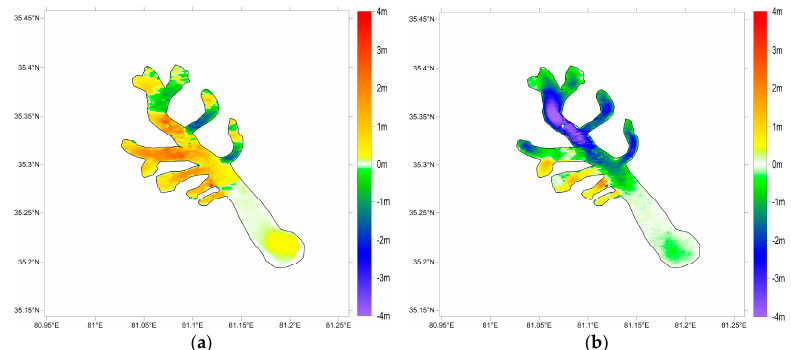
Figure 6. The integrated result of D-InSAR, MAI, and PT. ( a ) D-InSAR and PT in the across-track direction; and ( b ) MAI and PT in the along-track direction.